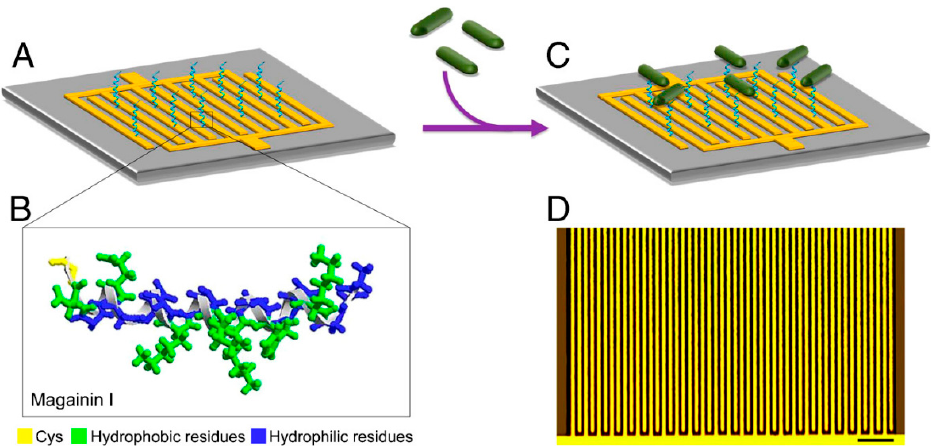
Figure 3. AMP-based device for the electrical detection of bacterial pathogens. ( A ) Schematic of the interdigitated microelectrode array, with immobilized AMPs. ( B ) Representation of the magainin I in helical form, with the added terminal cysteine residue, allowing its anchoring on gold. Hydrophobic and hydrophilic residues are highlighted to emphasize the amphiphilic nature of magainin I. ( C ) Binding of bacterial cells on the array, thus enabling the detection. ( D ) Optical image of the interdigitated microelectrode array (scale bar: 50 µm). Reproduced from [31].